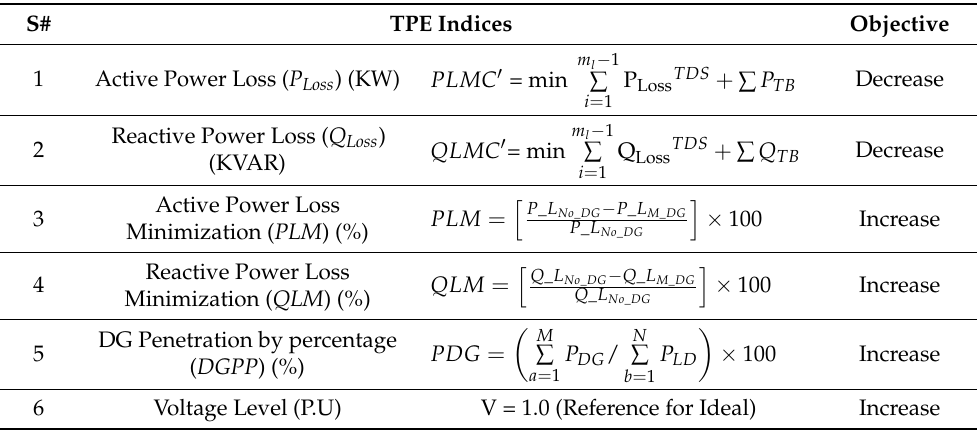
Table 3. Technical performance evaluation (TPE) indices [40–42].